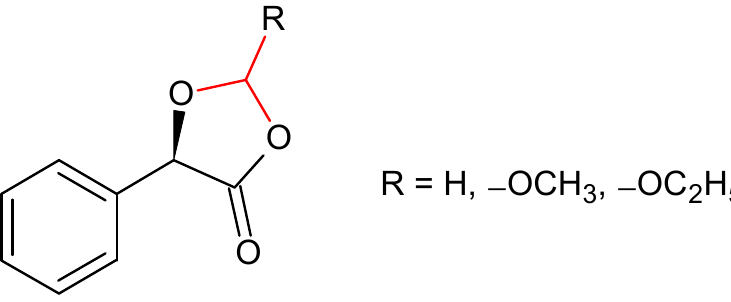
Figure 3. DOX, methyl-DOX, and ethyl-DOX.